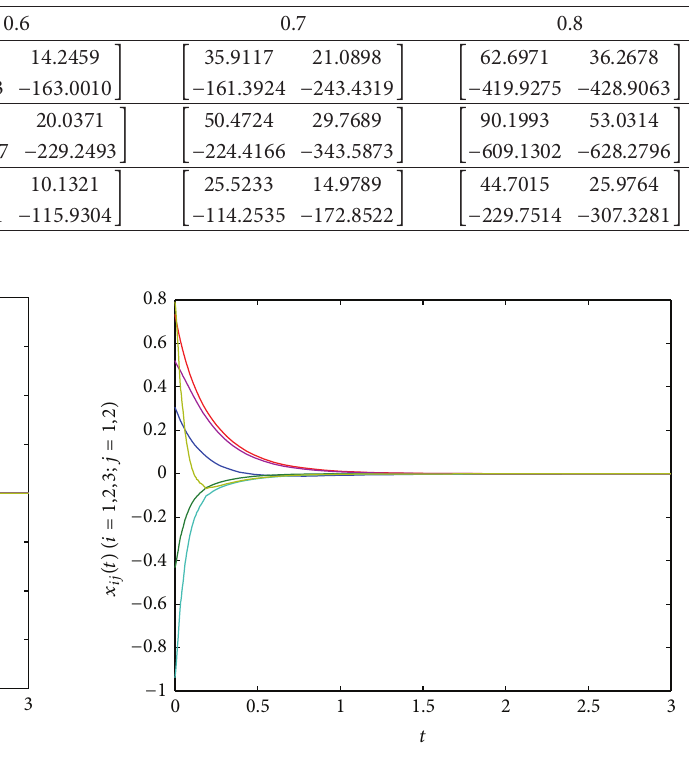
Figure 3: The position state curves of multiagent systems with 𝛼 0 = 0.7 , 𝜇 = 1.4 , and 𝜎 = 0.2 (measurement